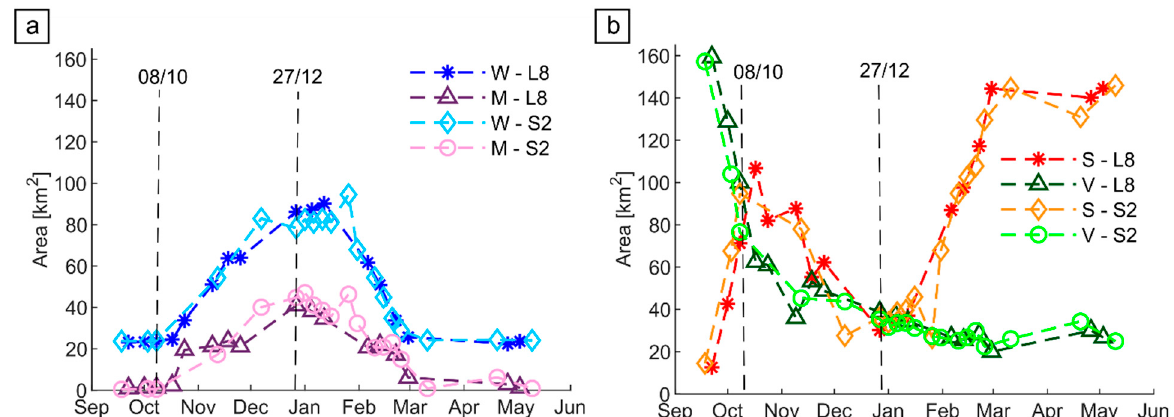
Figure 8. ( a ) Extent of W, M areas extracted by L8 and S2 in 2019/2020; ( b ) extent of S and V areas extracted by L8 and S2 in 2019/2020.